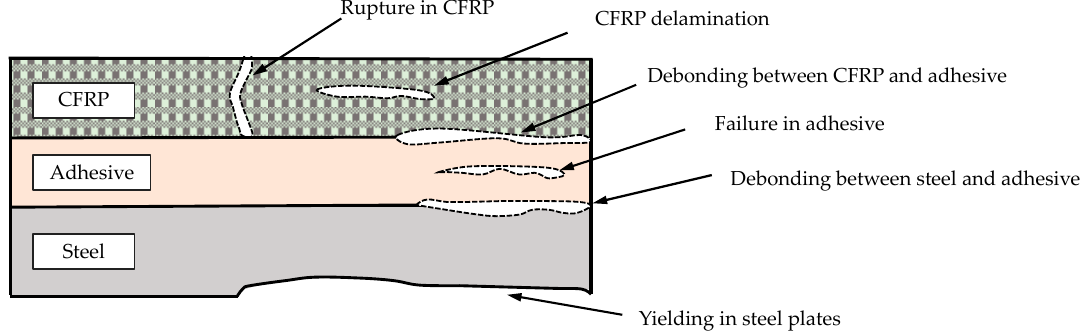
( a ) ( b ) Figure 13. Typical failure mode of loaded steel/CFRP DSJs subjected to quasi-static tensile loading; ( a ) CFRP rupture; ( b ) CFRP delamination.